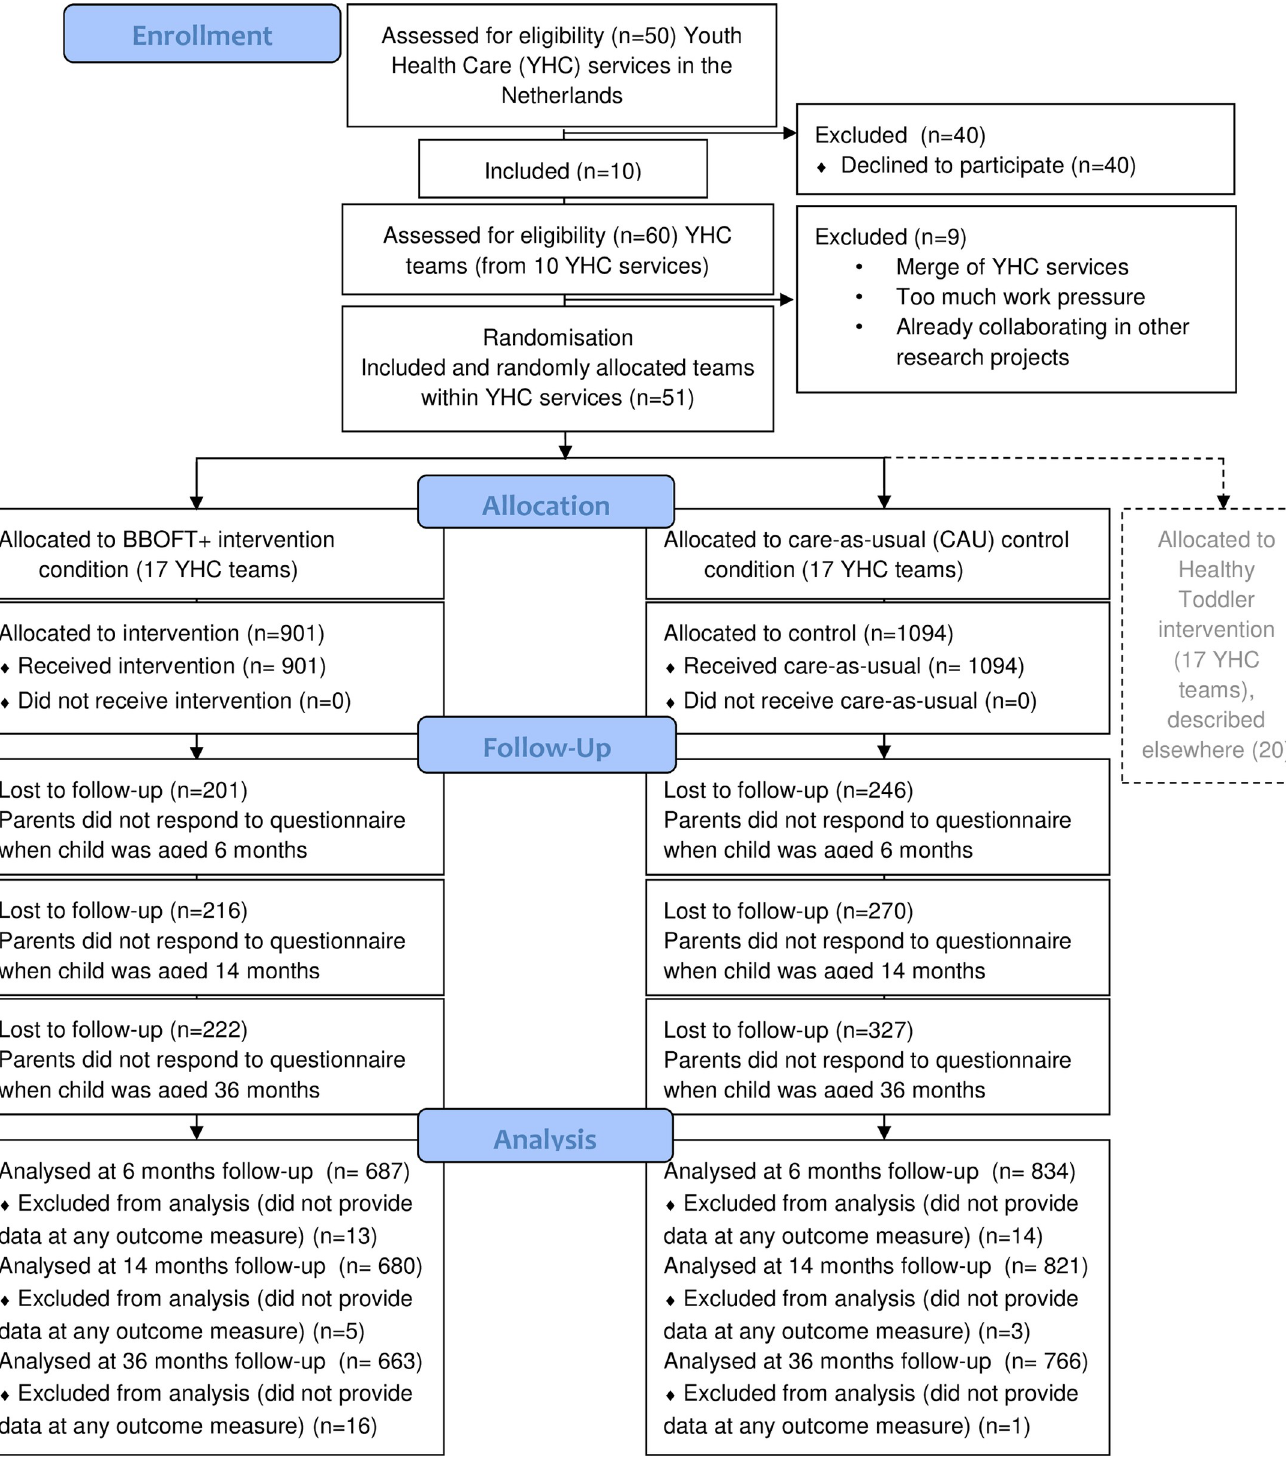
PLOS ONE | https://doi.org/10.1371/journal.pone.0237564 August 18,